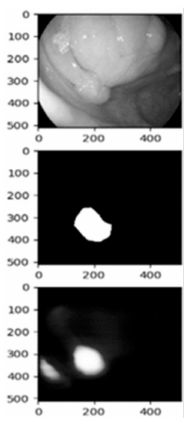
Figure 6. False detection of a polyp due to lighting